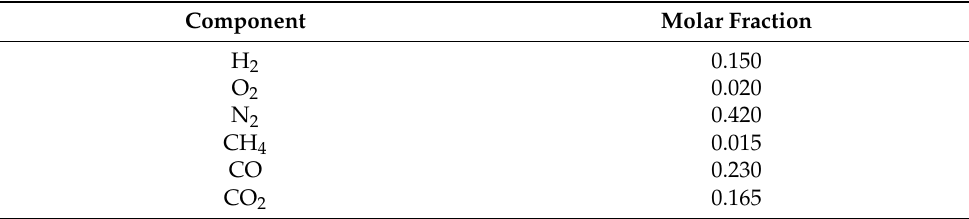
Table 2. Syngas composition.